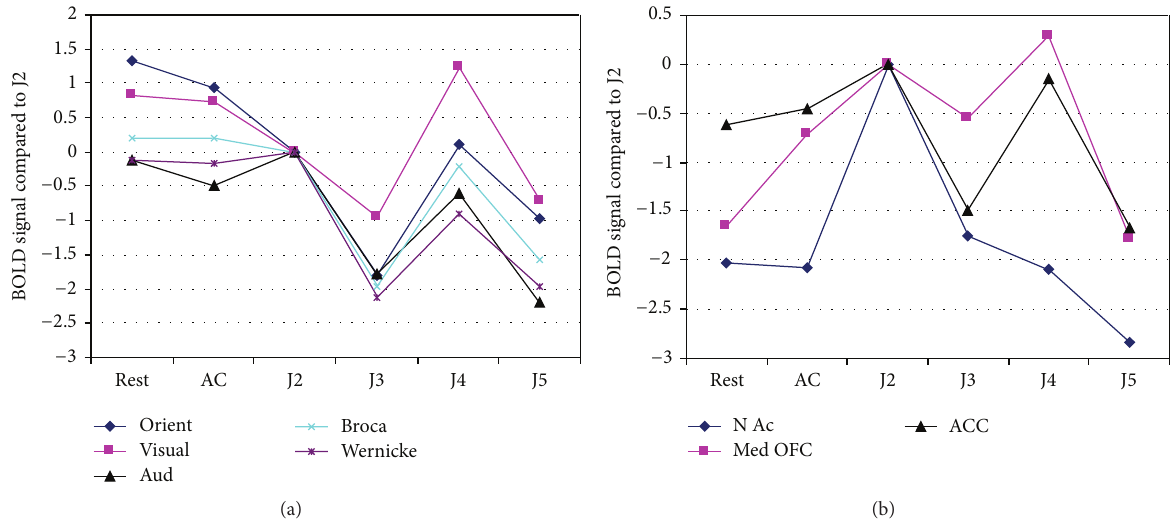
Figure 3: Average BOLD signal of each meditation state contrasted with J2 is shown on the 𝑦 -axis, with a separate line for each ROI. The 𝑥 -axis denotes each state from rest to AC to J2–J5. The mean SE of the signal contrasts averaged over the ROIs and states was ± .3. Note the high correlation between the lines in (a) and the steep increase in “NAc” at J2 in (b) (J1 was not recorded due to head movement